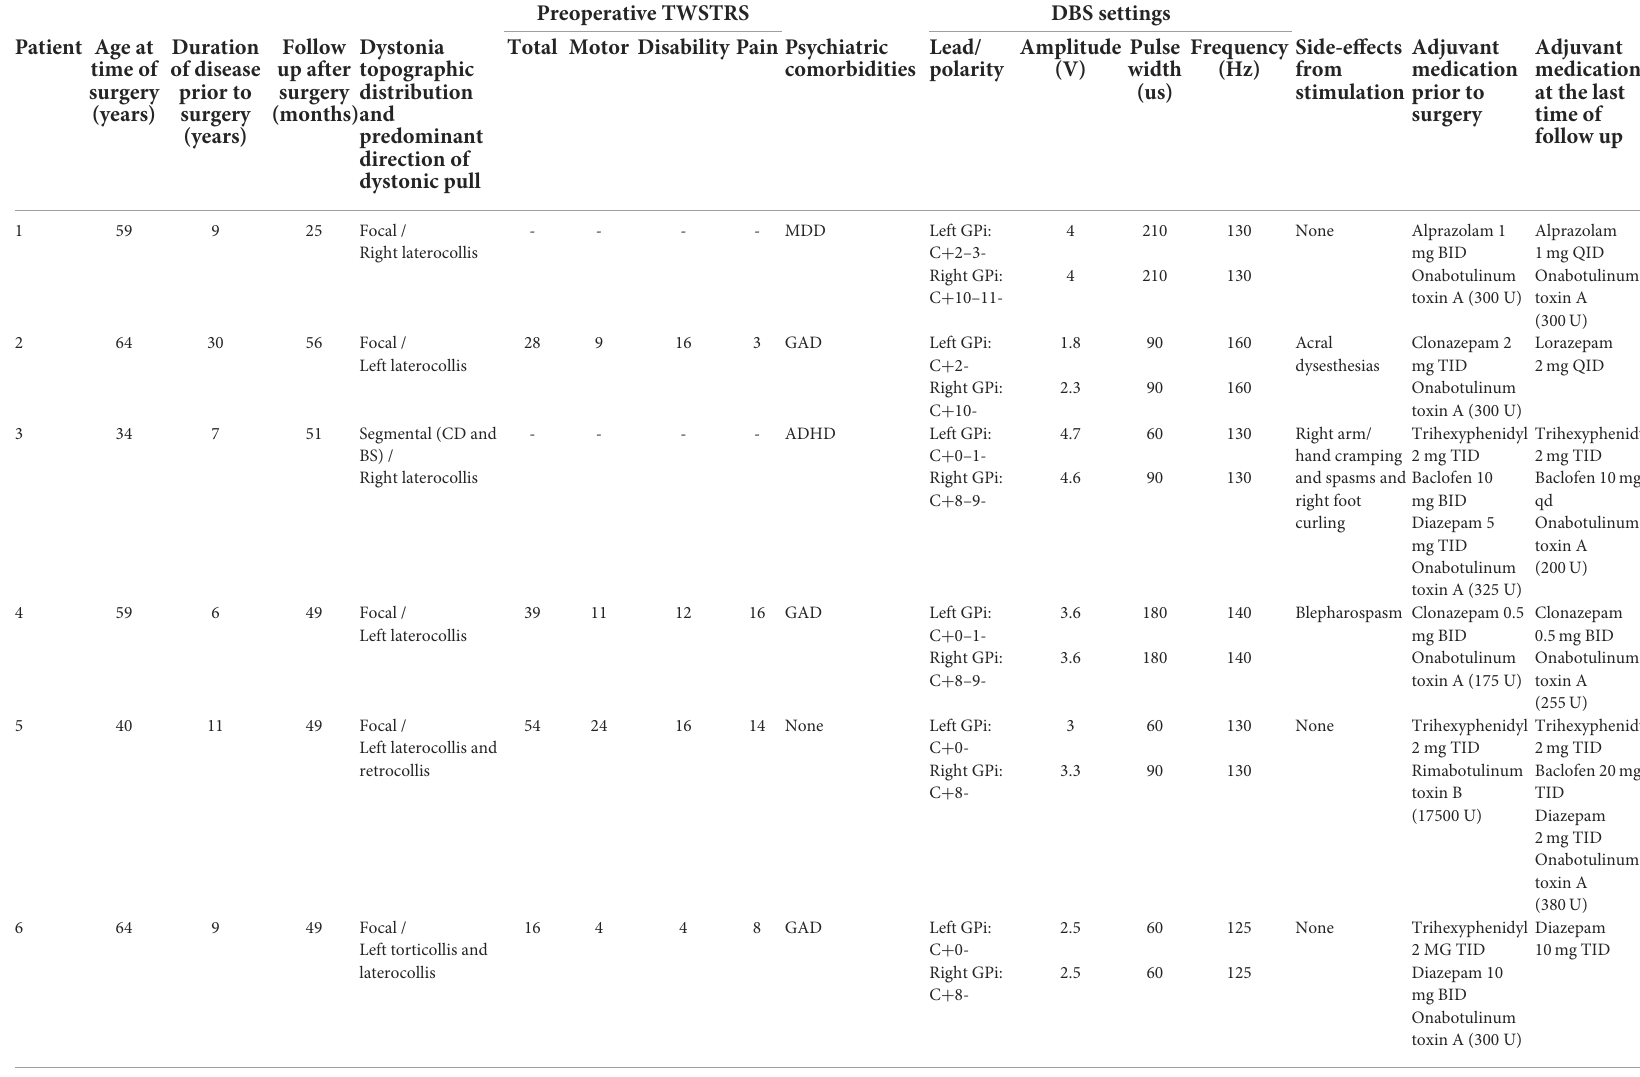
TABLE 2 Individual description of each of our patients including disease phenotype, stimulation parameters and adjuvant